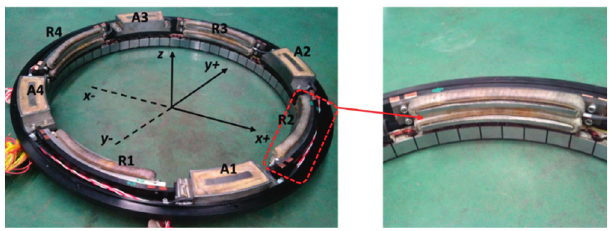
Figure 6: Radial AMB system and its single AMB.